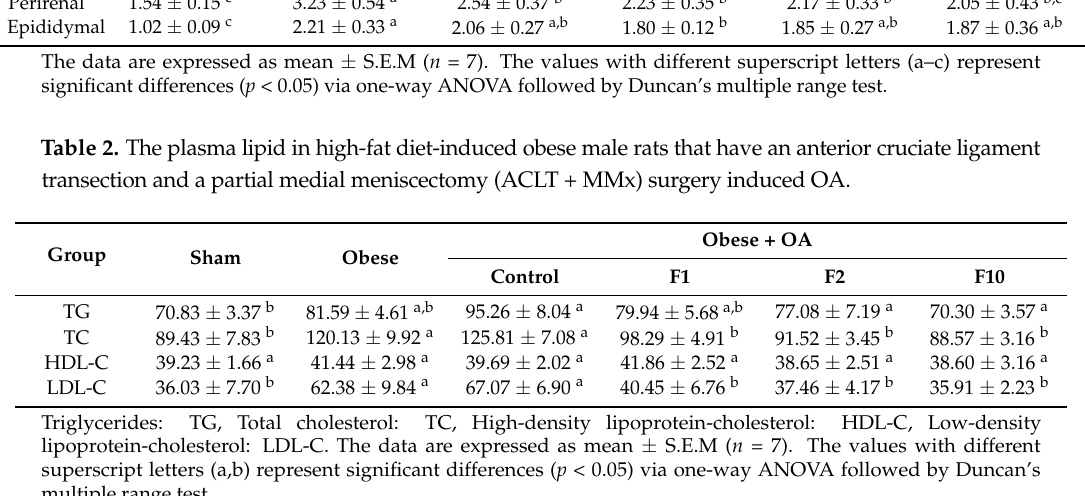
Triglycerides: TG, Total cholesterol: TC, High ‐ density lipoprotein ‐ cholesterol: HDL ‐ C, Low ‐ density lipoprotein ‐ cholesterol: LDL ‐ C. The data are expressed as mean ± S.E.M ( n = 7). The values with different superscript letters (a,b) represent significant differences ( p < 0.05) via one ‐ way ANOVA followed by Duncan’s multiple range